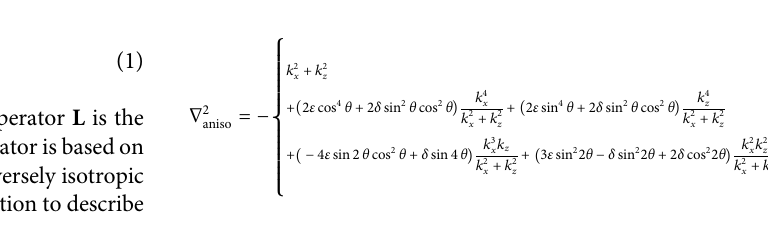
Frontiers in Earth Science |